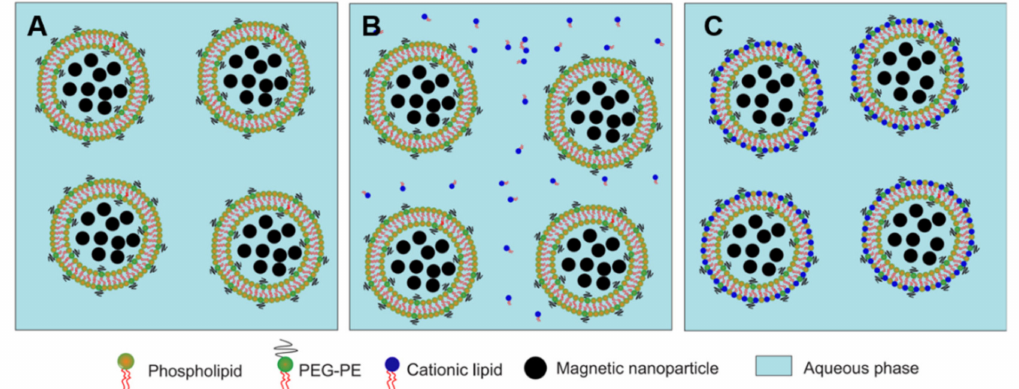
Figure 4. Diagram of MCLs preparation by post insertion method. Pre-formed UMLs were